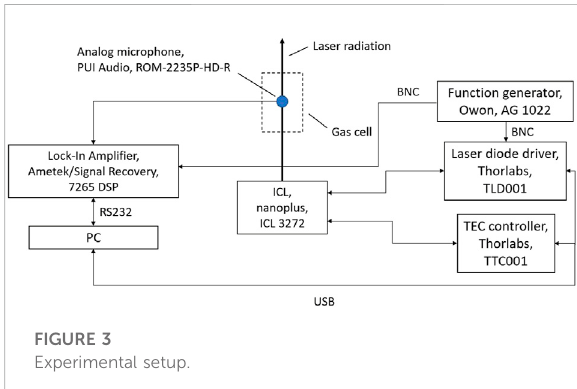
FIGURE 3 Experimental